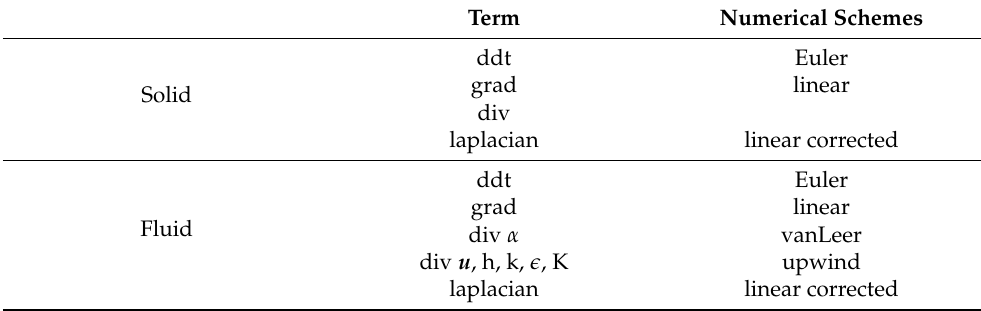
Table 3. Numerical schemes. Gauss theorem is used for values interpolation from cell centres to face